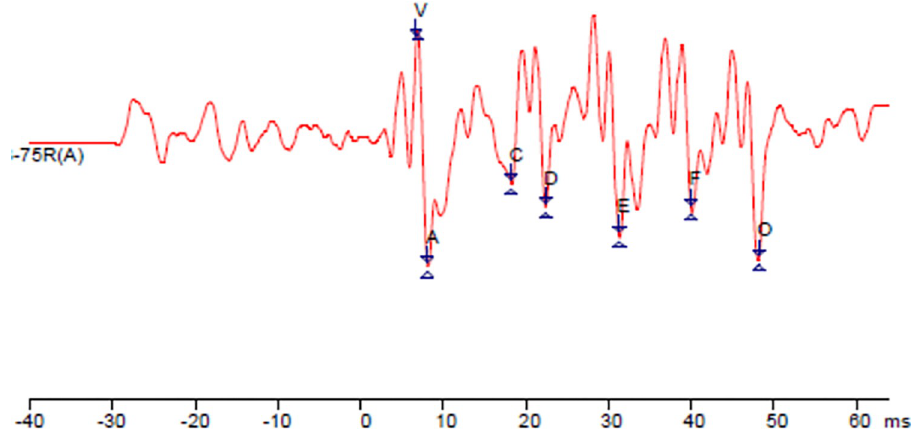
Fig 1. Representative illustration of the neural response evoked by the Frequency-Following Response of a six- year-old child. ms = milliseconds. Source: Author’s data. FFR performed using Smart EP. The labels in the waveform mark the FFR waves (V, A, C, D, E, F and O).